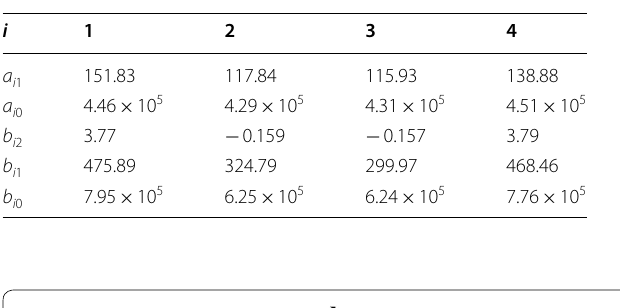
Table 2 Coefficients of identified transfer functions